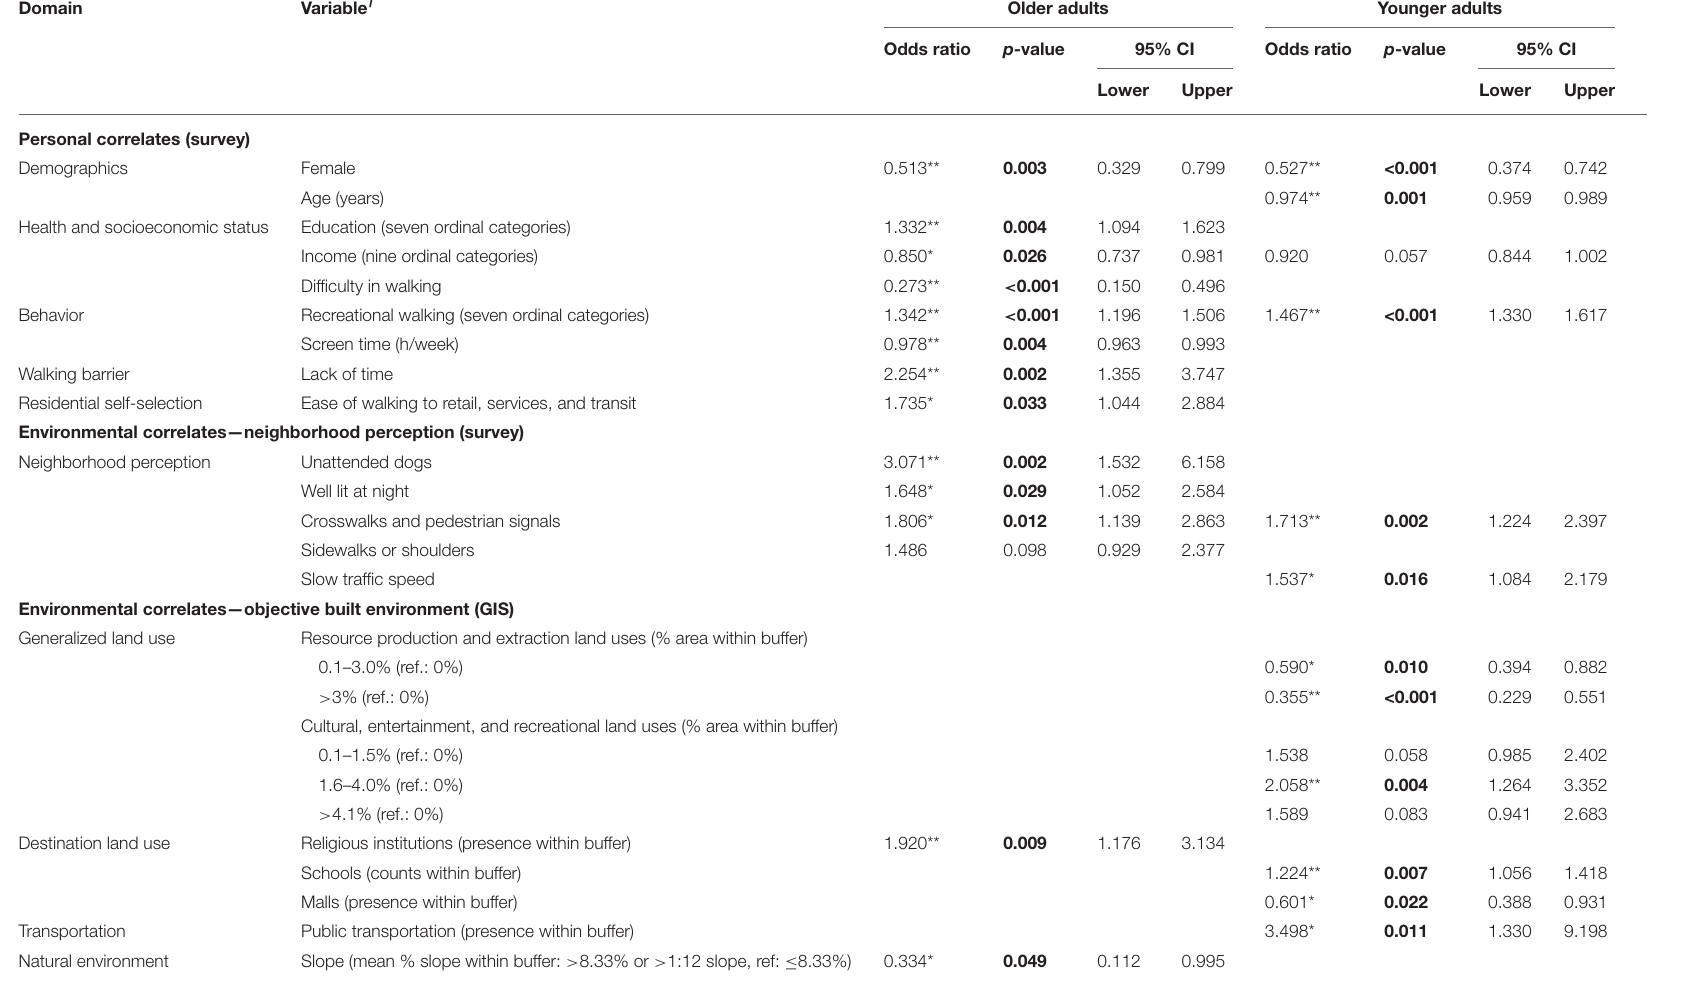
TABLE 4 | Multilevel correlates of neighborhood utilitarian walking among younger vs. older adults: results from multivariable mixed-effects